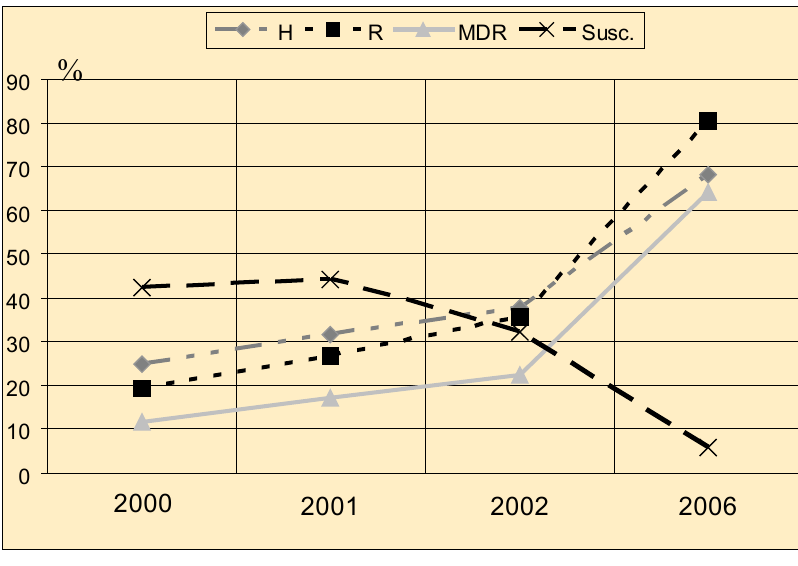
Figure 5. Level of acquired drug-resistance during years